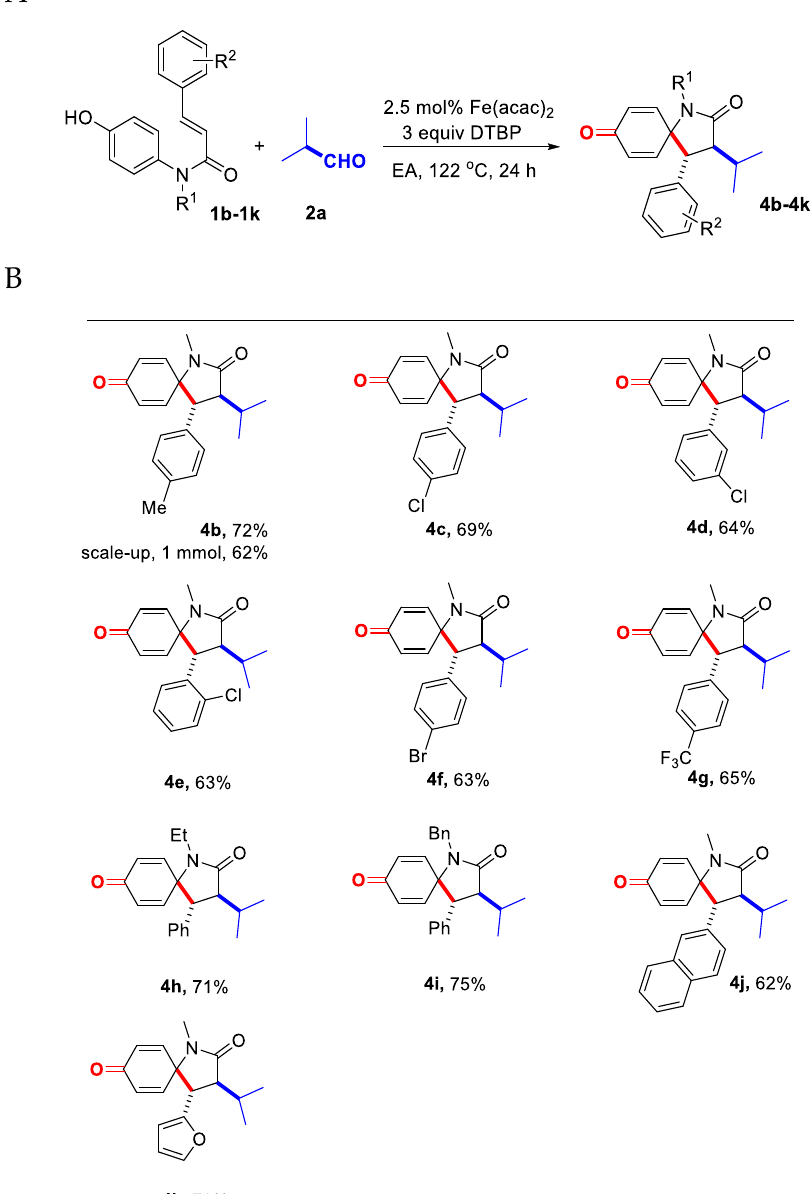
Figure 2. ( A ) Scope of the N -aryl cinnamamides. Conditions: cinnamamide 1b – 1k (0.1 mmol), aldehyde 2a (5 equiv, 0.5 mmol), Fe(acac) 2 (2.5 mol%) in EA (0.5 mL, prepared solution) and DTBP (3 equiv, 0.3 mmol) were reacted at 122 °C (oil bath temperature) for 24 h under air atmosphere. Isolated yield. ( B ) 4b – 4k .